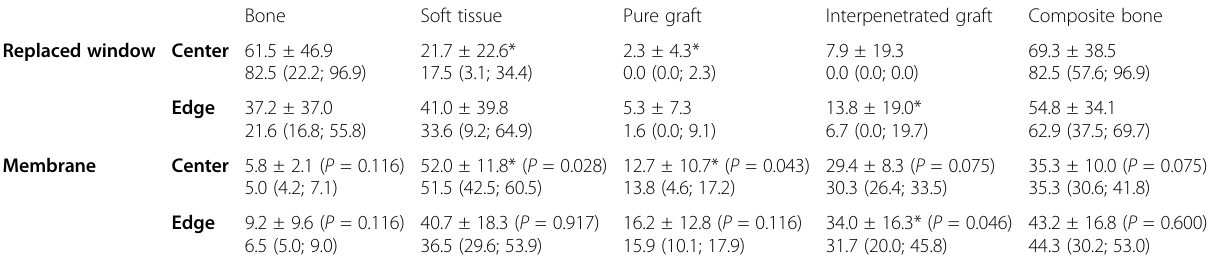
Table 2 Percentages of various tissues in the antrostomy area after 4 months of healing. Mean values ± standard deviations ( P values) and median (25%; 75% percentiles)